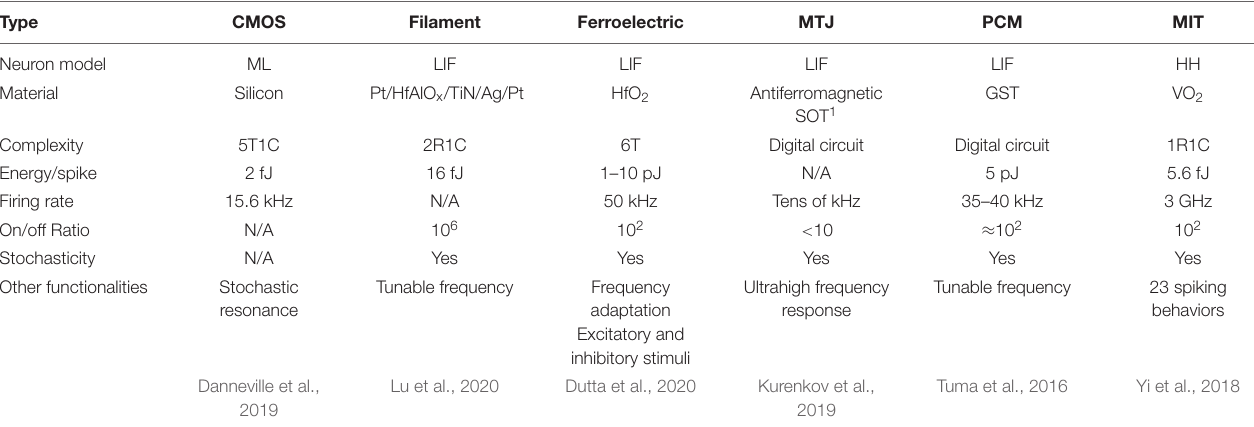
FIGURE 11 | (A) Top panel depicts a circuit diagram of a Hodgkin–Huxley (HH) neuron based on two VO 2 memristors. The bottom panel denotes the device structure. (B) Stochastic output spikes under a constant voltage (Yi et al., 2018). (C) The left panel represents the VO 2 -based neuron circuit with the VO 2 device in series with a tunable resistor. The right panel indicates the MIT neuron with the thermal and threshold noises. (D) Instantaneous firing under multiple values of v gs . (E) Firing rate plotted against v gs using the analytical and experimental results for different v h distributions (Parihar et al., 2018). TABLE 1 | Comparison between various hardware implementations of artificial